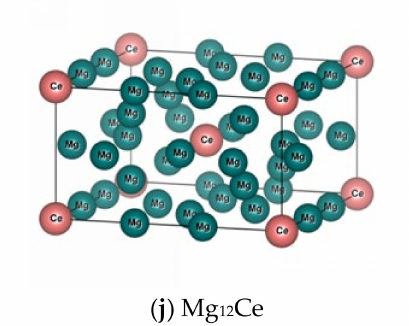
Figure 1. Crystal structure of the possible second phases in Mg-Al-Ce ternary alloy.